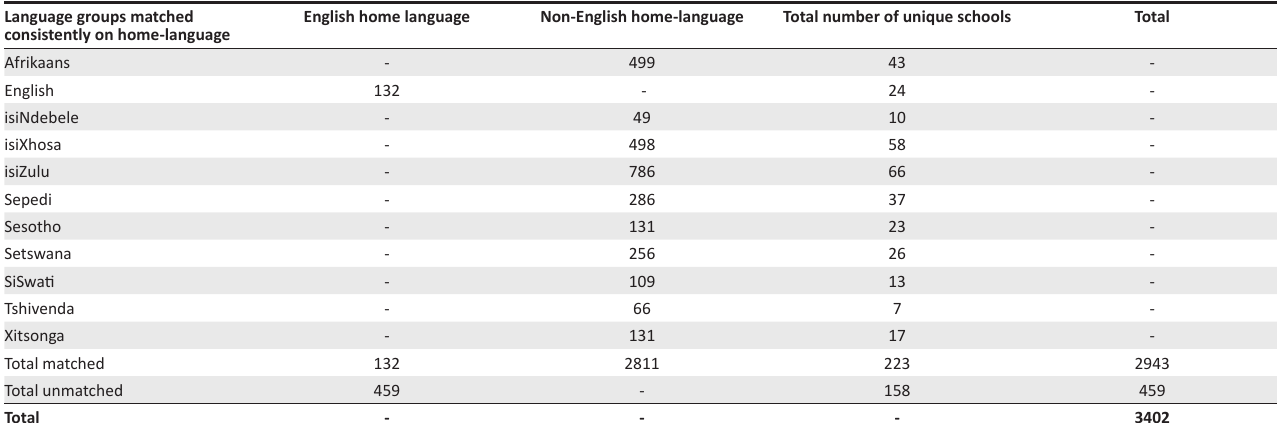
TABLE 7: Total number of students matched consistently on home-language variable between Systemic Evaluation and National School Effectiveness Study. Language groups matched consistently on